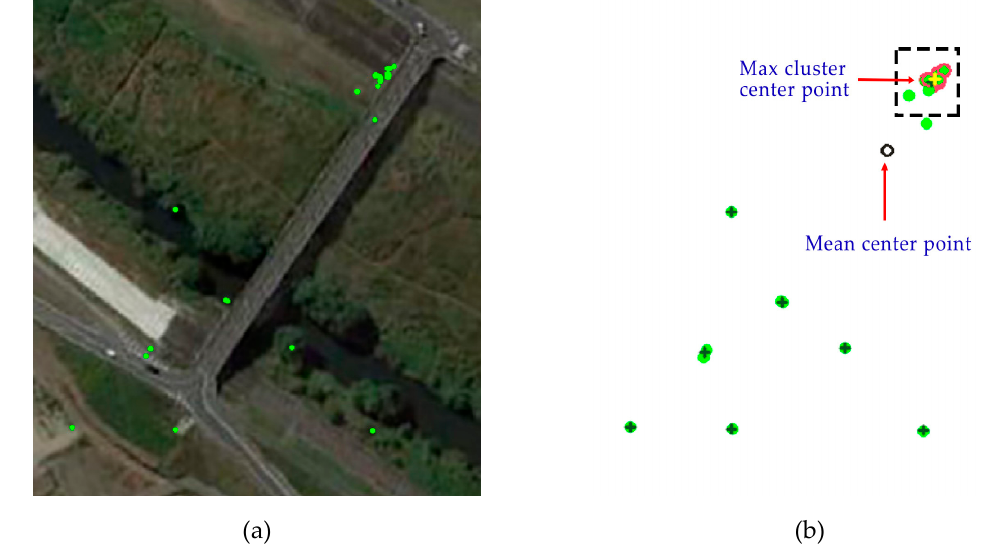
Figure 5. ( a ) One grid field from the initial match figure with detected feature points (represented as green dots). ( b ) Clustering of the same feature points, where the green circle and red circle represent the match points, the black cross represents the clustering center points, the yellow cross represents the maximum clustering center points, the black circle represents the mean center points, and the dotted box represents the maximum clustering area.